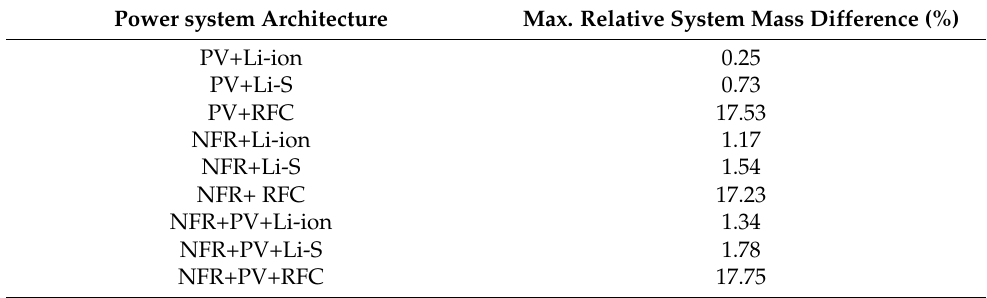
Table 12. Maximum relative differences in the total system mass based on the data for 0 ◦ , 30 ◦ , 60 ◦ and 89 ◦ selenographic latitude.